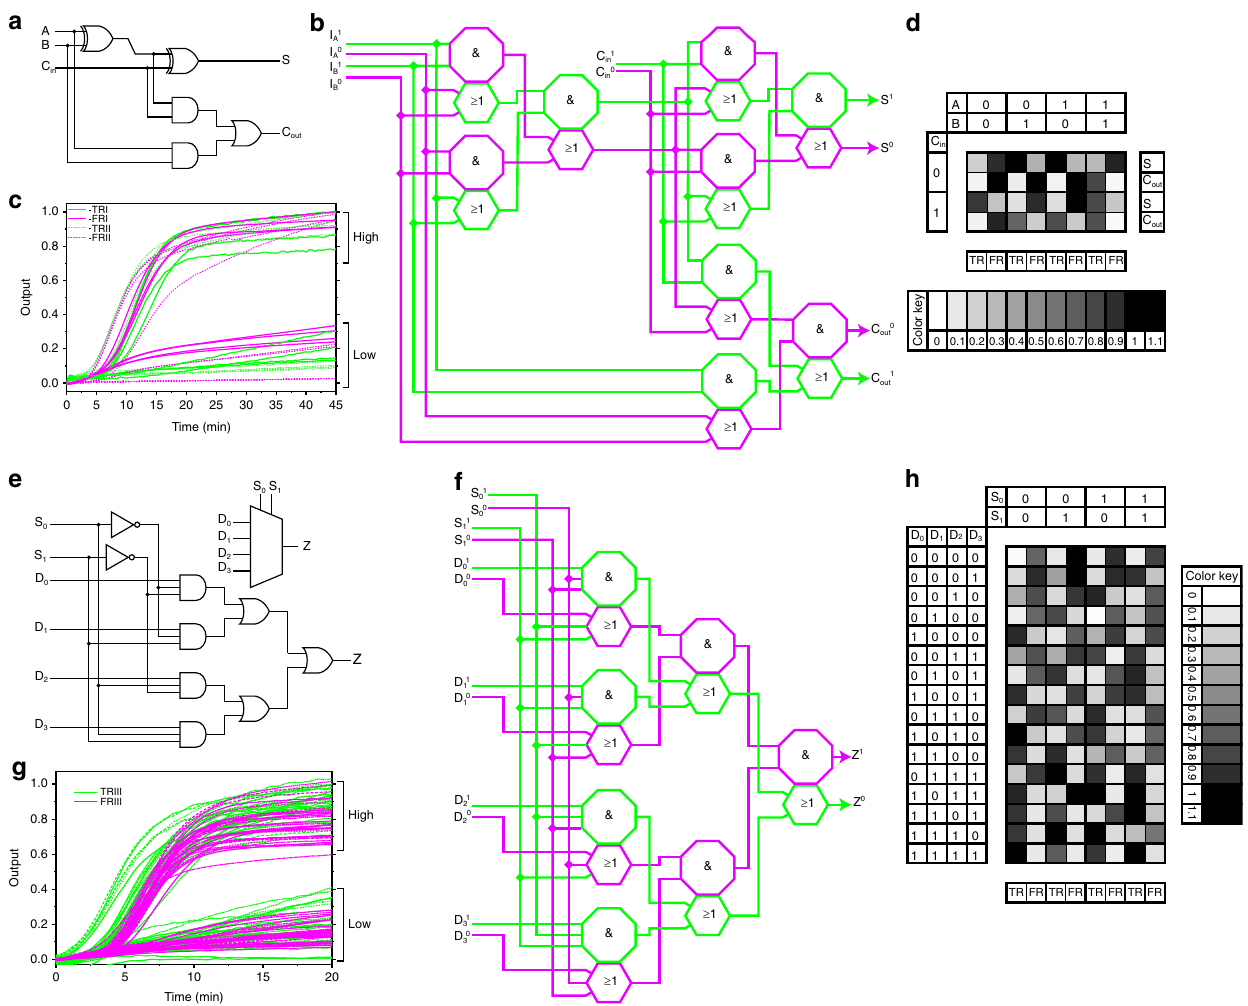
Fig. 3 Construction of the full adder and 4:1 multiplexer from our DNA logic gates. a , e A typical construction of the full adder and the 4:1 multiplexer with the digital logic circuit. D 0 – D 3 : inputs; S 0 and S 1 : select signals; Z: output. b , f Constructing a full adder and the 4:1 multiplexer with DNA logic gates. The sequences of the DNA strands are listed in the Supplementary table 2. c , g Summary of all the outputs computed by the DNA full adder and 4:1 multiplexer. d , h Reaction kinetics of the full adder and the 4:1 multiplexer with all possible combinations of inputs. For the full adder, the reaction was performed with 12 U Bst polymerase (large fragment), TRI, FRI, TRII, and FRII. The outputs were normalized to the RFU values in the FAM, ROX, HEX, and Cy5 channels with the highest signals. For the full adder: The TRI (FAM) and FRI (ROX) signals correspond to TRUE and FALSE returns of S, respectively. The TRII (HEX) and FRII (Cy5) signals correspond to the TRUE and FALSE returns of C out, respectively. For the 4:1 multiplexer, the reaction was performed with 6.4 U Bst polymerase (large fragment), TRIII and FRII. The outputs were normalized to the RFU values in the FAM and ROX channels with the highest signals. The TRIII (FAM) and FRIII (ROX) signals correspond to TRUE and FALSE returns, respectively. The reaction kinetics of the individual gates can be seen in Supplementary Figs. 14 and